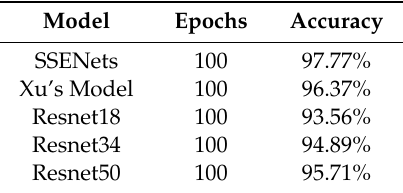
Table 1. Experimental results of di ff erent